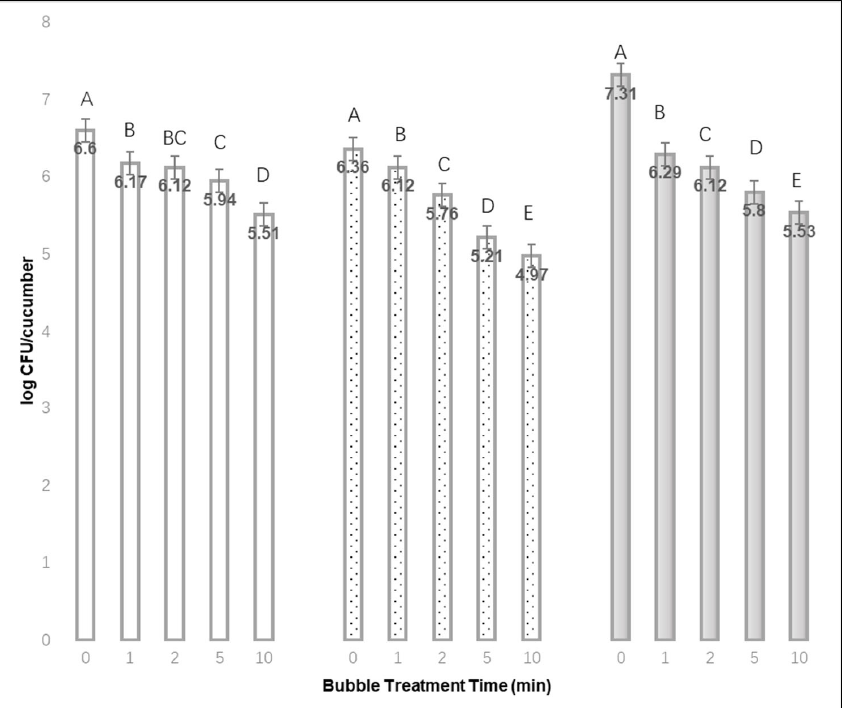
Figure 2. The mean log CFU Listeria monocytogenes recovered per cucumber after inoculum drying times of 1 h , 24 h , or 48 h , and different bubble treatment times from 0 to 10 min (Mean of 3 replications × 3 samples each). A,B,C,D,E Denote significant differences in recovery ( p < 0.01) between treatment times for each of the inoculum drying times.